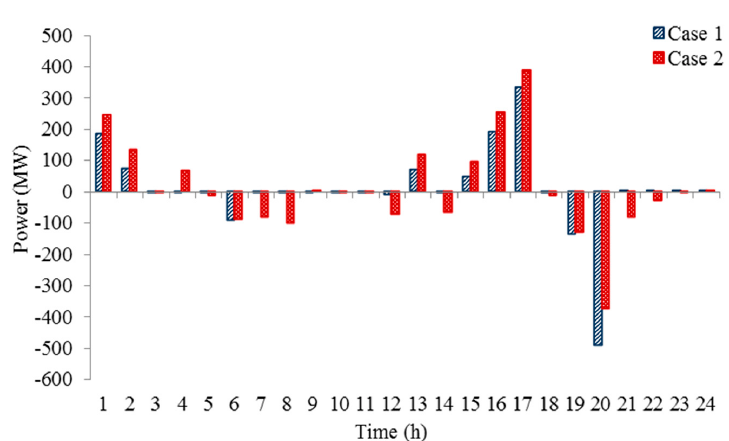
Figure 16. Power output comparisons of pumped storage in Case 1 and Case 2.